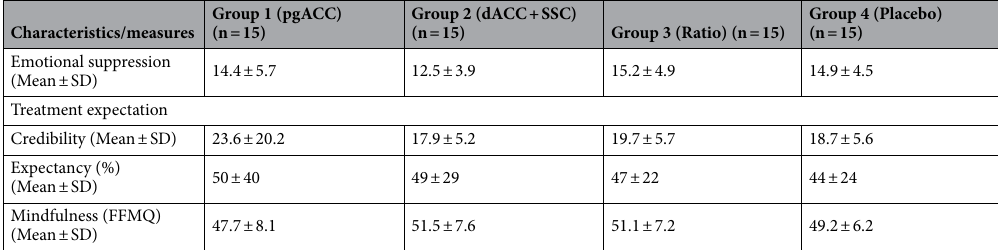
Table 1. Demographics and clinical characteristics of participants.